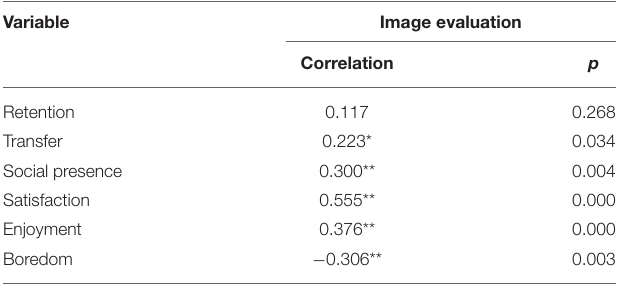
TABLE 3 | Correlation coefficients of each variable and image evaluation ( N = 122).